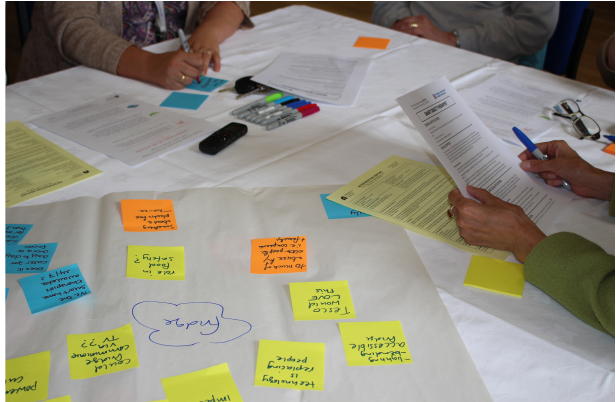
Figure 1. Workshop participants interacting with the SOT design fiction material and leaving feedback